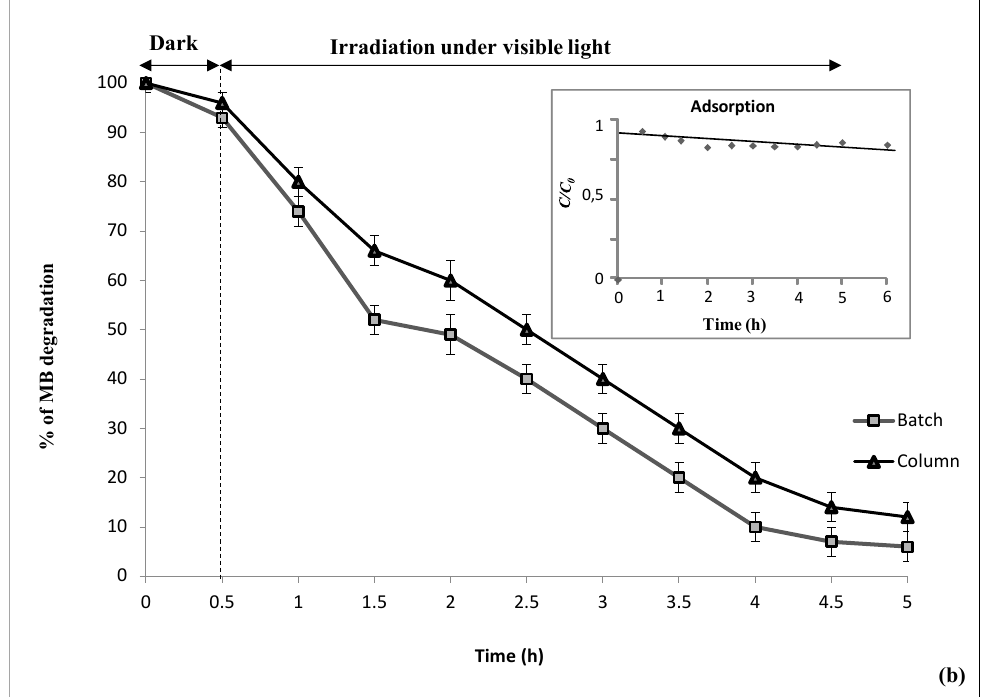
Figure 6. Kinetics of methylene blue degradation in the dark and under visible light irradiation by ( a ) the goethite nanoparticles and PAN nanofiber; ( b ) the natural nanocomposite fiber in static (batch) and continuous (column) photoreactors.